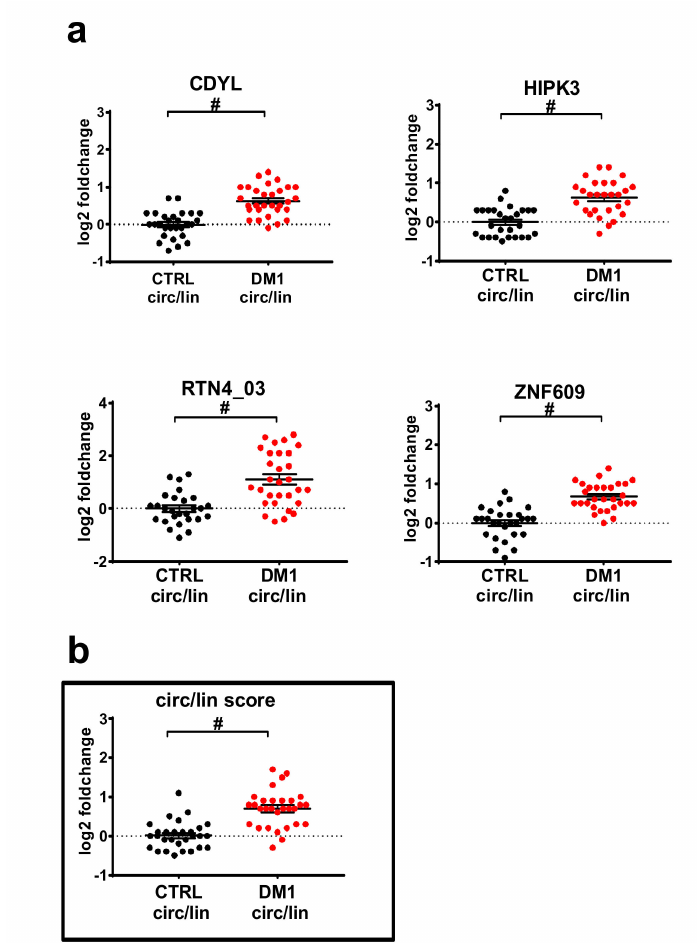
Figure 1. Di ff erentially modulated circular-to-linear ratios in DM1 biceps brachii. ( a ) Scatterplots in log2 scale of significantly di ff erent circular-to-linear ratios identified by qPCR in DM1 muscle tissue compared to the control (CTRL). After normality testing, statistical significance was calculated either by a t -test or a Mann-Whitney test (threshold p < 0.05), followed by correction multiple comparison, with significance threshold set at q < 0.01. ( b ) Scatterplot of circular-to-linear ratio score (circ / lin score), estimated by averaging the log2 fold changes of significantly di ff erent circular-to-linear ratios in DM1 muscle tissue compared to the control. For both panels, lines indicate mean and standard error values for each group. DM1 = 30 (red dots); CTRL = 29 (black dots); # q <